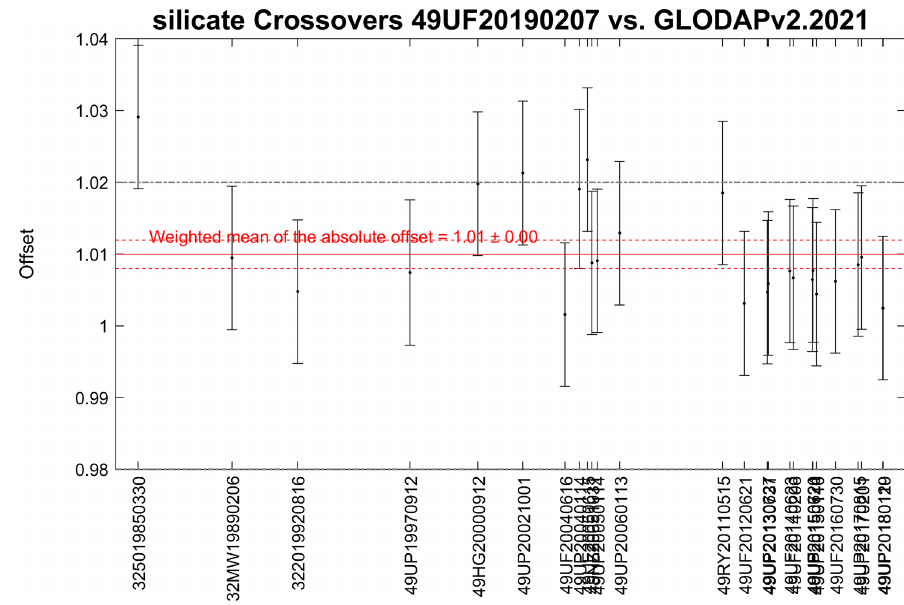
Figure 4. Example summary figure for silicate crossovers for 49UF20190207 versus the cruises in GLODAPv2.2021 (with cruise EX- POCODE listed on the x axis sorted according to the year the cruise was conducted). The black dots and vertical error bars show the weighted mean offset and standard deviation for each crossover (as a ratio). The weighted mean and standard deviation of all these offsets are shown in the red lines and are 1.01 ± 0.00. The dashed black lines are the reference line for a ± 2%